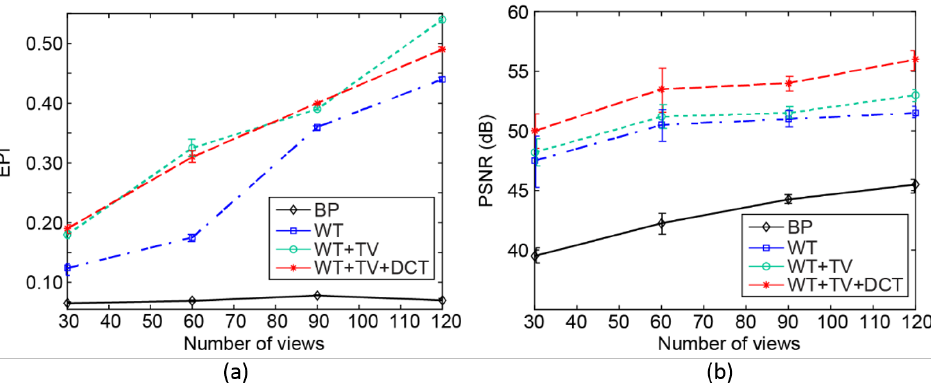
Figure 6. Quantitative evaluation, ( a ) EPI and ( b ) PSNR, of the performance of four reconstruction algorithms with different number of view